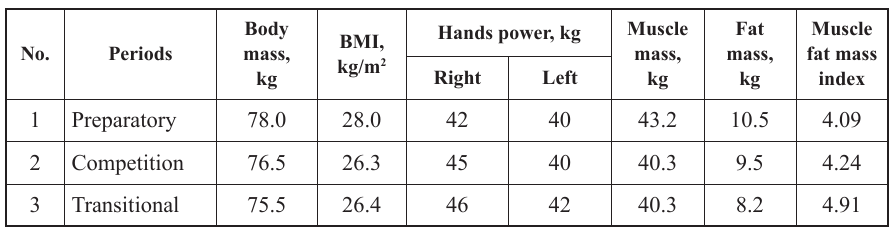
Table 2. Alternation of female BMX cyclist single muscular contraction power (SMCP) and anaerobic alactate muscular power (AAMP) indices during yearly training cycle